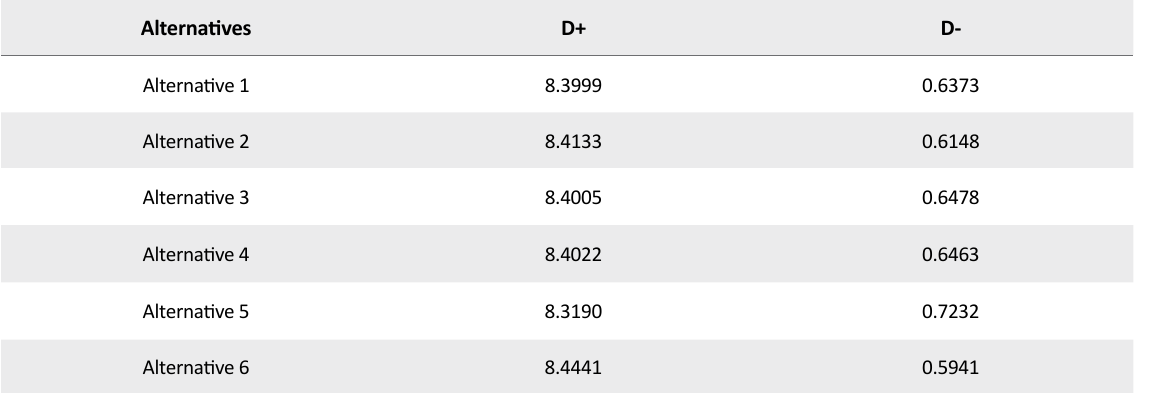
Table 12. Distance of alternatives from positive and negative ideal points in fuzzy TOPSIS method